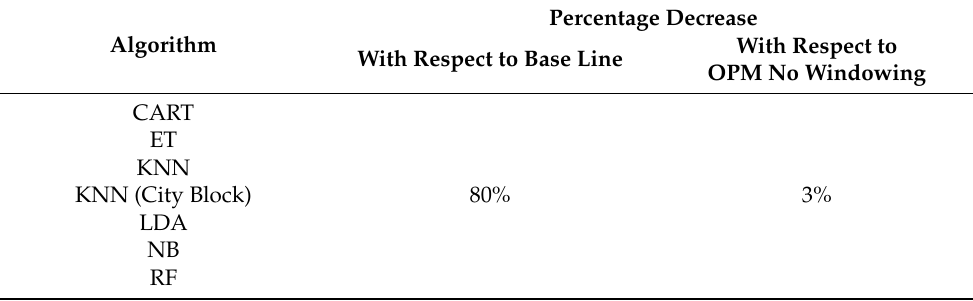
Table 8. Percentage decrease in